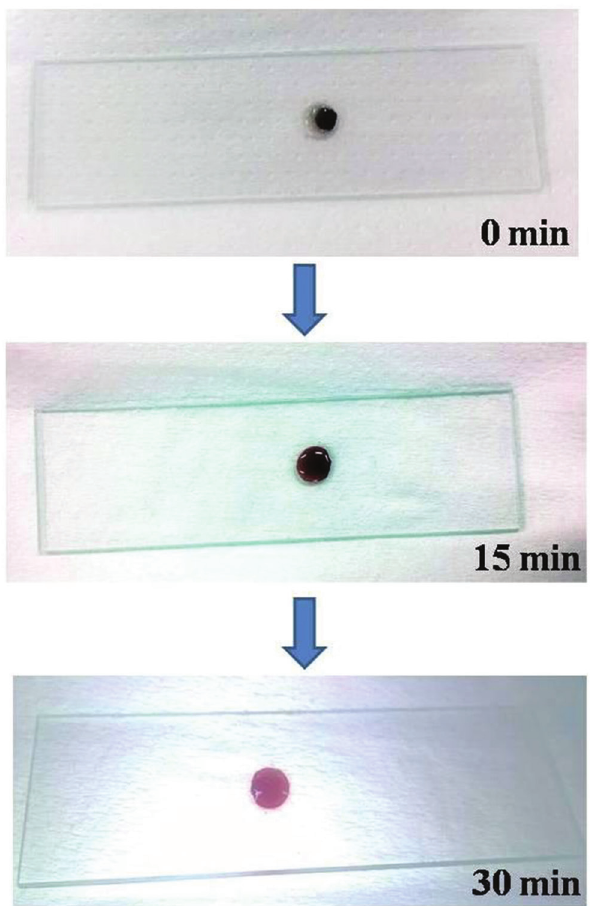
Figure 10: Thrombolytic activity of silver